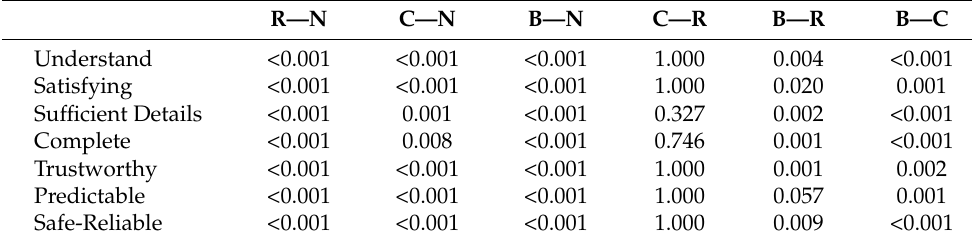
Table 5. Table of the p -values obtained from Dunn’s test for the comparison of the actual explanations. R—N C—N B—N C—R B—R